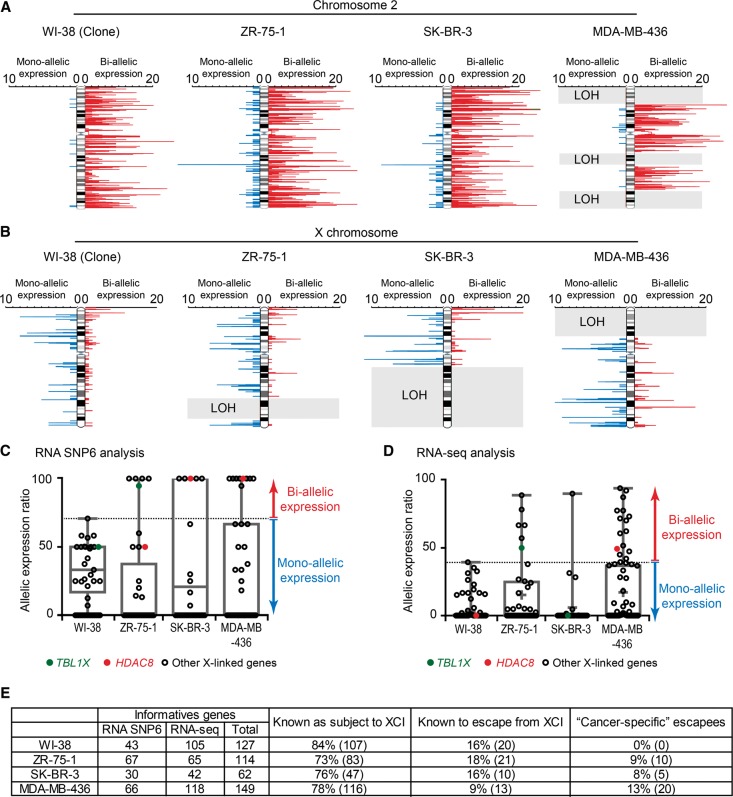
Abnormal reactivation of the inactive X chromosome in breast cancer cell lines. (A,B) RNA SNP6 analysis shows the expression status of an autosomal chromosome, as example Chromosome 2 (A), and the X chromosome (B) in normal (WI-38) and breast cancer cell lines (ZR-75-1, SK-BR-3, and MDA-MB-436). Red bars indicate biallelic expression, and blue bars indicate monoallelic expression. The bar length represents the number of expressed informative SNPs on a 50-SNP sliding window. Gray rectangles correspond to noninformative regions due to loss of heterozygosity (LOH). Two WI-38 subclones (#1 and #28), carrying an inactive X chromosome of opposite parental origin, show clear monoallelic expression from either the maternal or paternal X chromosome confirming the clonality of the subclones (see Supplemental Fig. S4B). Allele-specific PCR analysis also confirmed the clonality of the three breast tumor cell lines (see Supplemental Fig. S4C–E). (C) RNA SNP6 analysis shows levels of X-linked gene allelic expression. X-linked genes known as subject to XCI (Carrel and Willard 2005; Cotton et al. 2013) and/or considered as monoallelically expressed in WI-38 clones (i.e., for each informative gene, <2/3 of the SNPs were observed as biallelically expressed) are shown on the boxplots. (D) RNA-seq analysis shows levels of X-linked gene allelic expression. X-linked shown on the boxplots are known to be subject to XCI (Carrel and Willard 2005; Cotton et al. 2013) and/or are considered as monoallelically expressed in WI-38 clones (i.e., for each informative gene, the allelic expression ratio is <40, i.e., expressed <20% on one of the two alleles). (E) Summary of the informative genes identified by the RNA SNP6 and RNA-seq approaches. Genes “known as subject to XCI” or “known to escape from XCI” refer to previous studies (Carrel and Willard 2005; Cotton et al. 2013). WI-38 data correspond to the two clones.